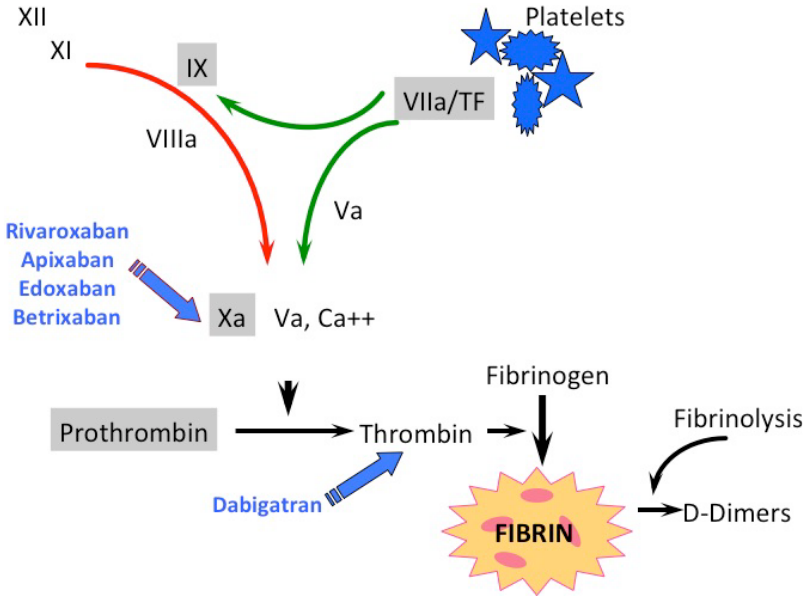
Figure 1 . Classical scheme of the coagulation cascade with direct oral anticoagulants (DOAC) and vitamin K antagonists (VKA) attack points. Coagulation enzymes are presented in roman numerals; green arrows depict the extrinsic and the red arrow the intrinsic coagulation pathway; the gray-shaded coagulation factors are vitamin K-dependent.